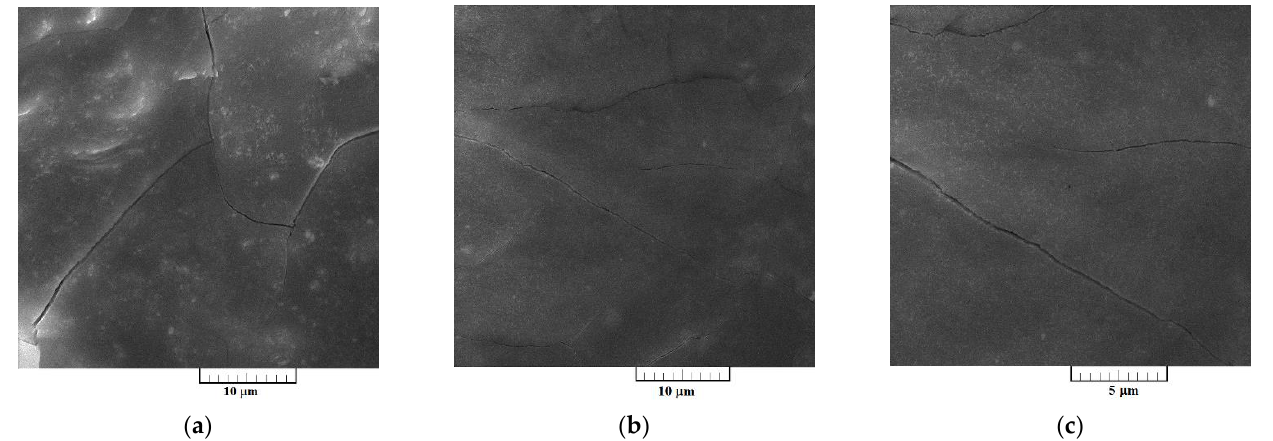
( b ) Figure 6. Hold on GC working electrode at potential E C = 0.050 V vs. Al; T = 200 °C, v = 100 mVs −1 ; in: ( a ) the equimolar melt containing anodically dissolved vanadium; ( b ) the equimolar melt with vanadium added by VCl 3 .